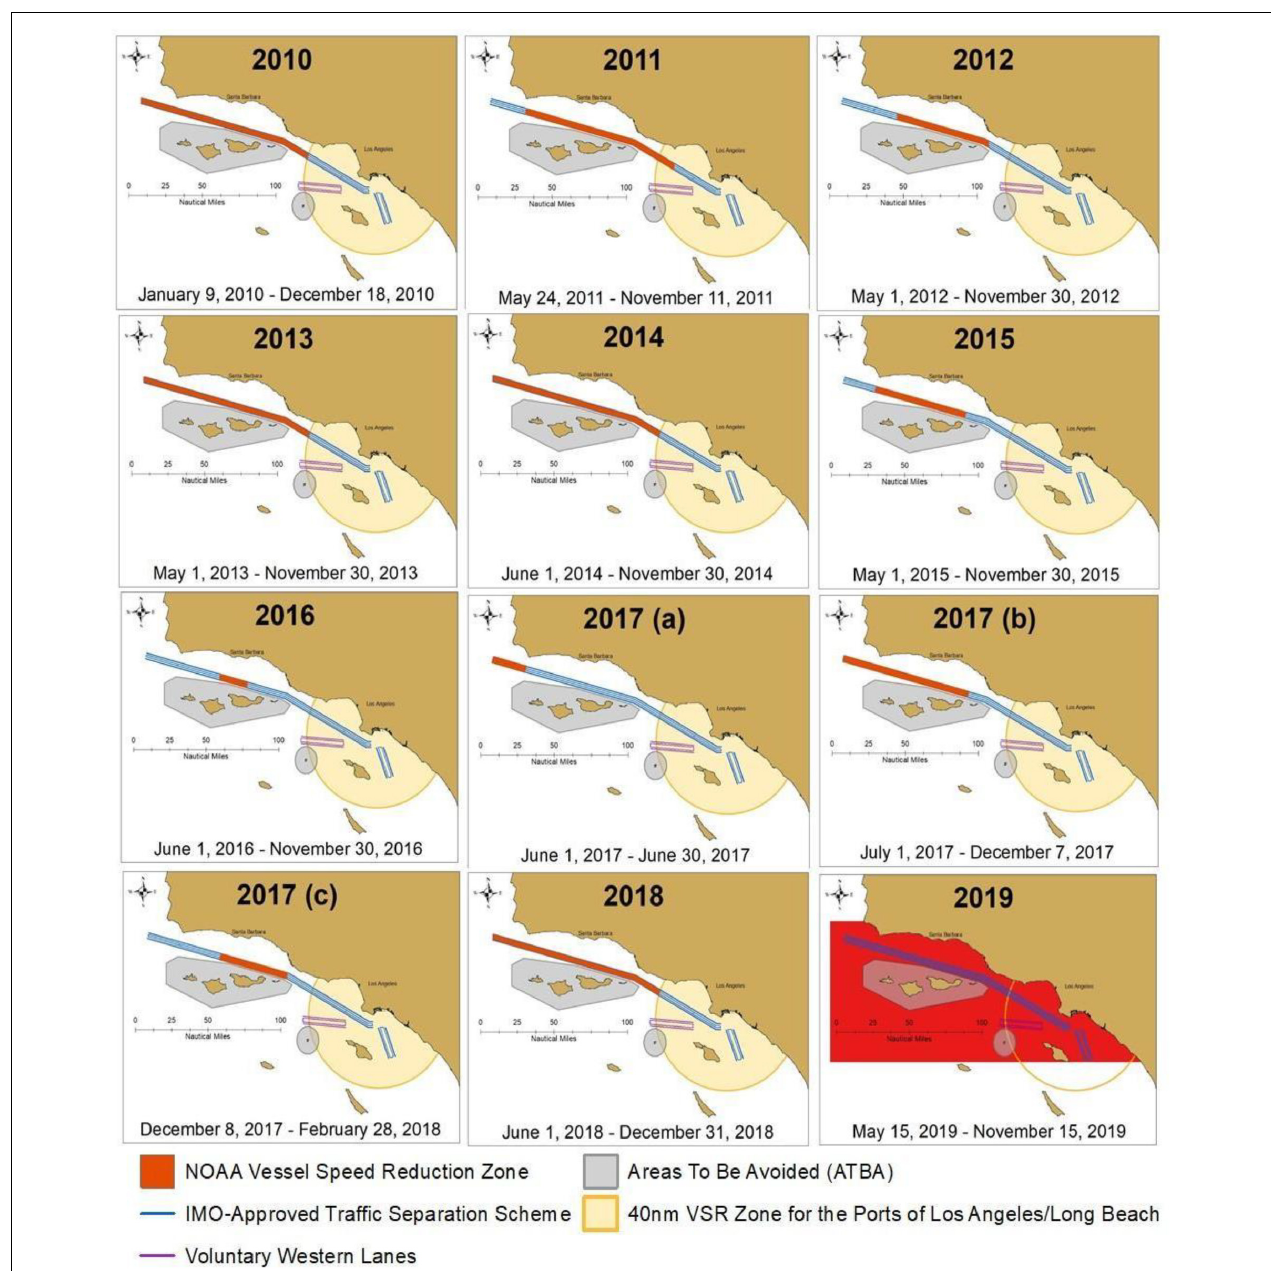
FIGURE 2 | NOAA Voluntary VSR zones 2010–2019, shown in red.